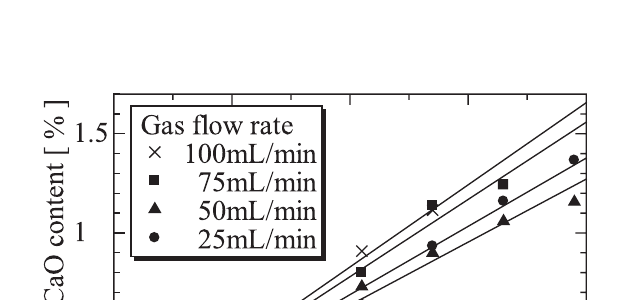
Table 3: Physical properties of slag